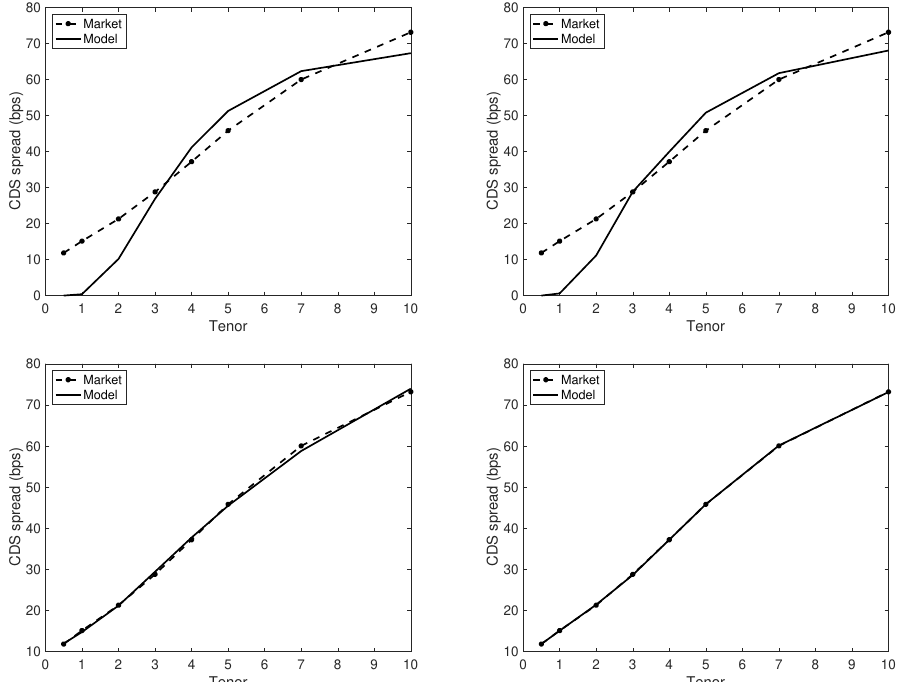
Figure 5. Graphs of CDS Spreads for four models: Black–Cox ( top-left ), occupation time ( top-right ), Alfonsi–Lelong ( bottom-left ), and hazard rate ( bottom-right ). The underlying firm’s value is GBM.